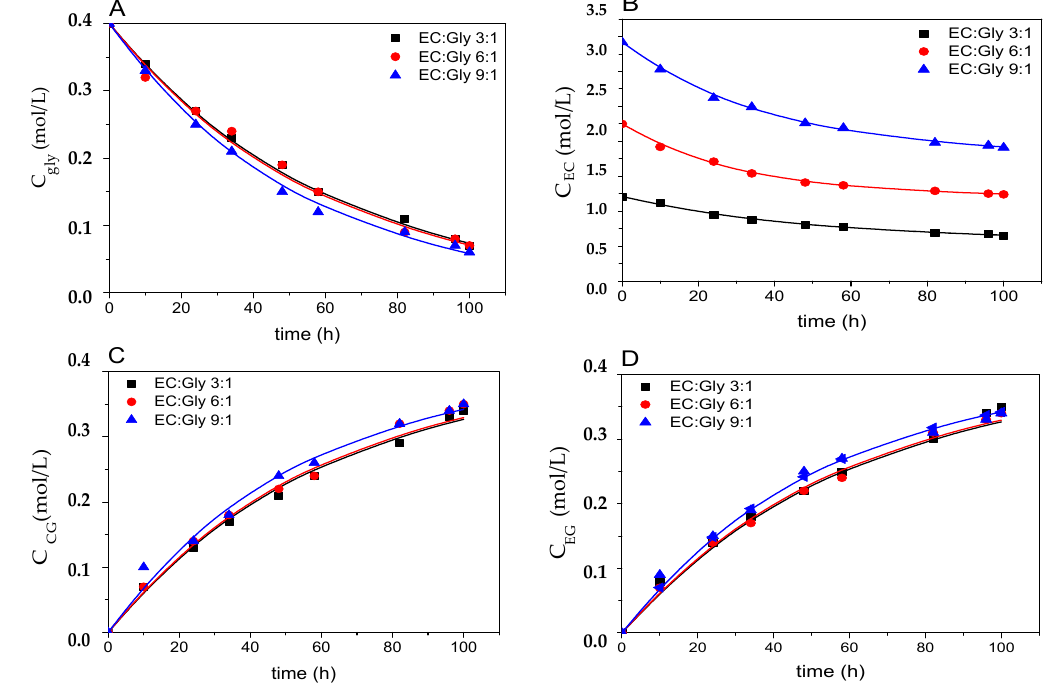
Figure 10. Fitting of the kinetic model proposed to runs 1, 2, and 3 (molar ratios EC:Gly 1:3, 1:6, and 1:9, respectively). Subfigure ( A ) shows results for glycerol, ( B ) for ethylene carbonate, ( C ) for glycerol carbonate, and ( D ) for ethylene glycol. Other conditions: enzyme load: 3% w / w ; solvent: tert-butanol (30% v / v ); closed stirred batch reactor; agitation speed: 400 rpm; T = 50 °C .